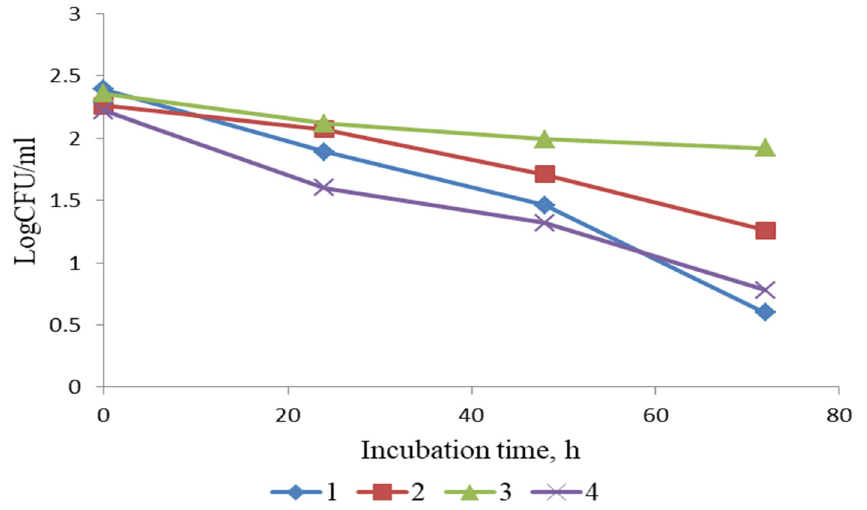
Figure 7. Growth curves of Saccharomyces cerevisiae Y-564 yeast cells with and without the Amelanchier ovalis berry extract: 0.25, 0.5, and 1.0 mg/mL: 1—0.25 mg/mL; 2—0.5 mg/mL; 3—1.0 mg/mL; 4—H 2 O 2 .